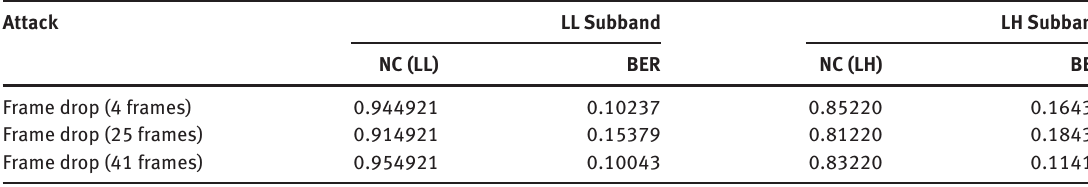
Table 8: Robustness against Frame Dropping Attack.